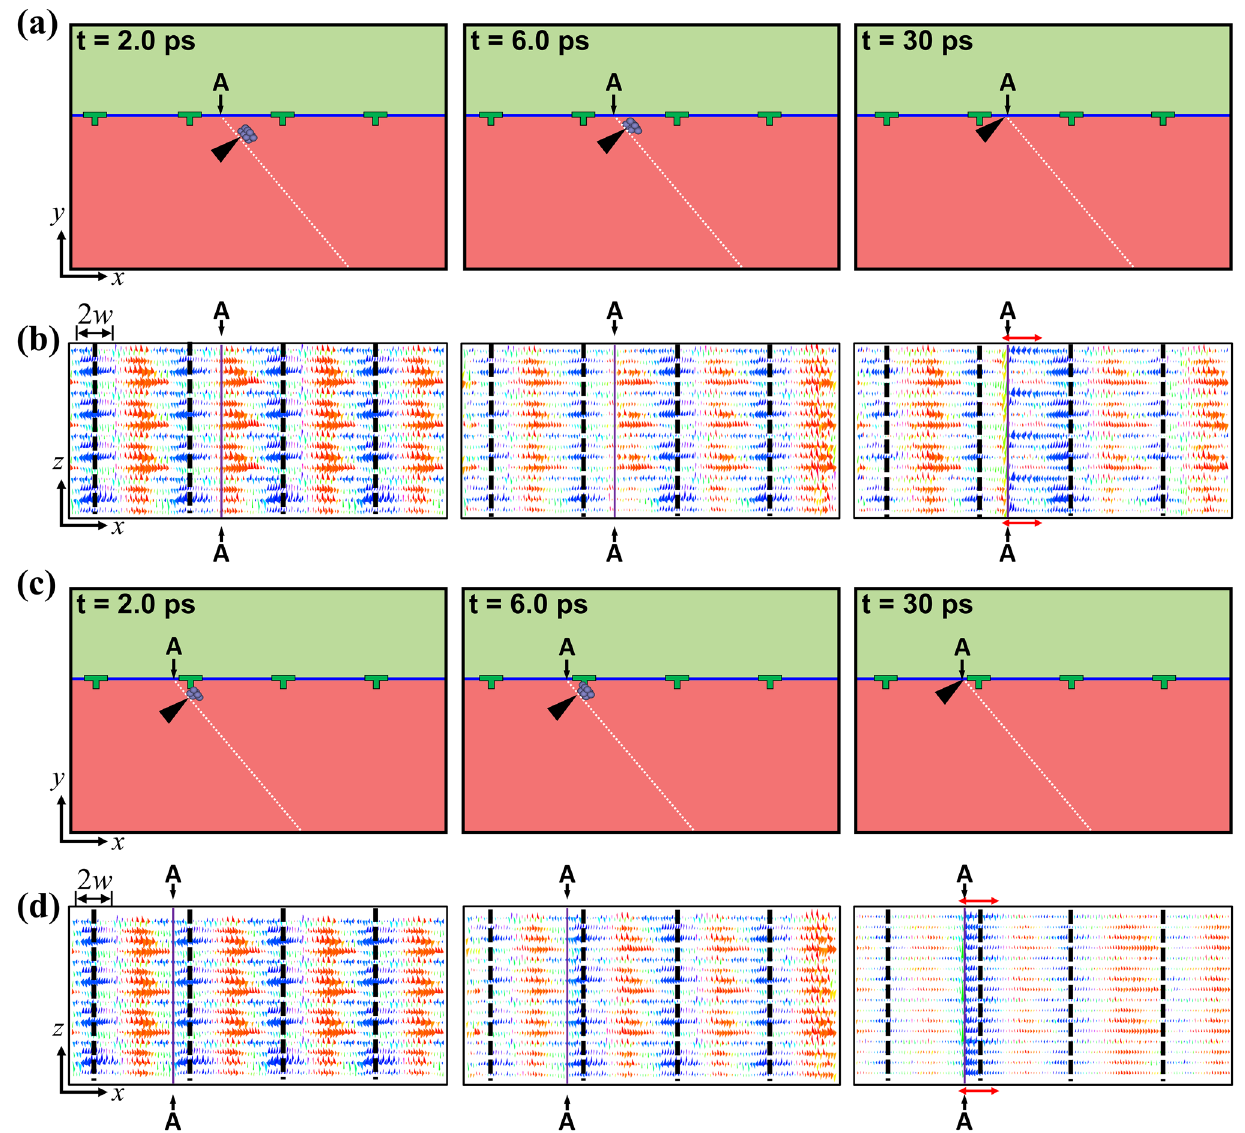
Figure 4. Trajectory of lattice dislocation trapping for the lattice dislocation located at ( a ) P middle and ( c ) P core positions as equilibration time increases at 50 K. Corresponded 2D disregistry map of interface atoms for the lattice dislocation located at ( b ) P middle and ( d ) P core positions. The vertical distance of lattice dislocation in ( a ) and ( c ) is 0.7 nm. The equilibration simulation is carried out at 50 K to compute the clear disregistry plot. The black triangle in ( a ) and ( c ) indicates the position of the lattice dislocation. Solid blue and dashed white lines in ( a ) and ( c ) indicate the ferrite/cementite interface and the slip plane in the ferrite layer, respectively. The black dashed line and purple solid line in ( b ) and ( d ) represent misfit dislocation line and slip plane trace, respectively. 2 w and red arrow in ( b ) and ( d ) represent the core width of misfit dislocation and core spreading of lattice dislocation along the interface,